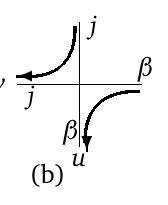
Figure 2: Two moves of the indices.